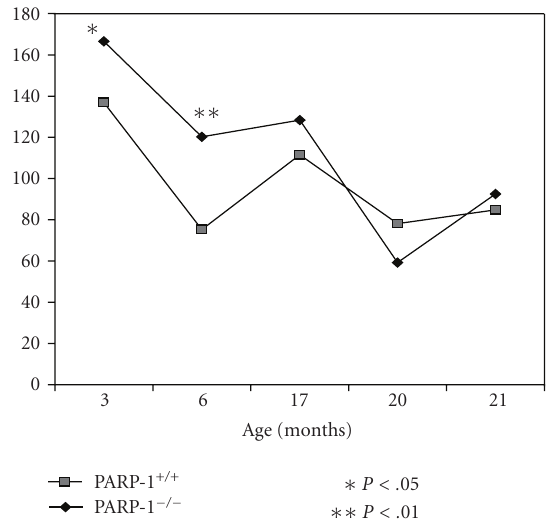
Figure 3: Age-related locomotor activity (“open field” test) in PARP-1 − / − and PARP-1 + / + mice. PARP-1 − / − and PARP-1 + / + mice were tested for their behavior by “open field” at the indicated age. The vertical axis represents the number of crossed squares at indicated age. Student’s t test was performed to analyze the statistical significance of the results.